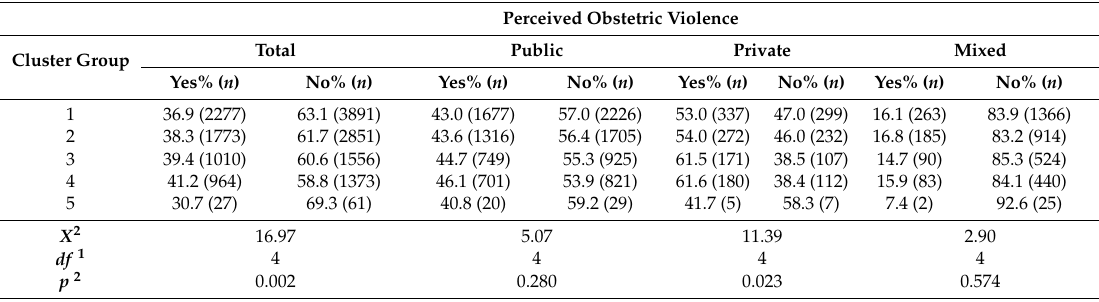
Table 2. Descriptive data about the variable perceiving Obstetric Violence according to the cluster group and the type of attention received ( n = 15783).